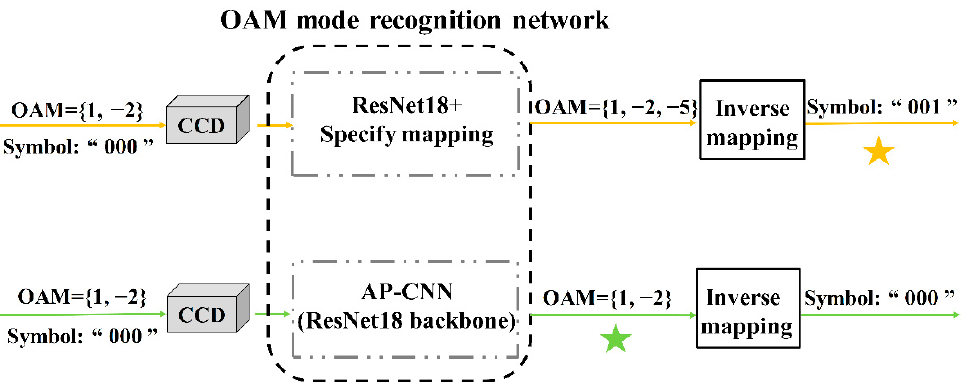
Figure 11. Comparison of the optimization direction of the AP-CNN and specified mapping relationship. Table 3. Detection accuracy comparison of single mode OAM mode using ResNet18 and AP-CNN. C n 2 / ( m − 2 / 3 )